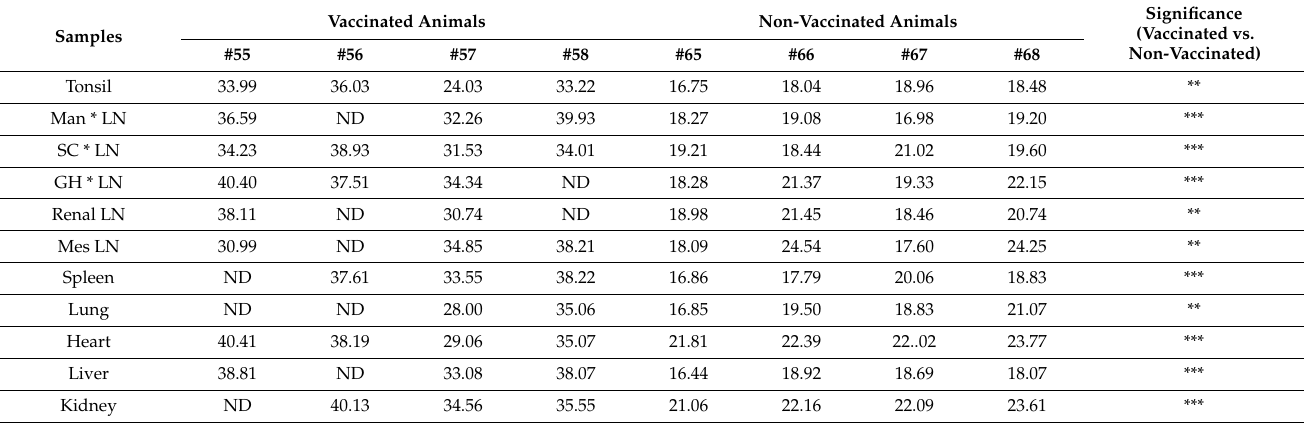
Table 4. Viremia detected by qPCR in the indicated tissues in vaccinated (#55–58) and non-vaccinated (#65–68) animals at 21 dpc.